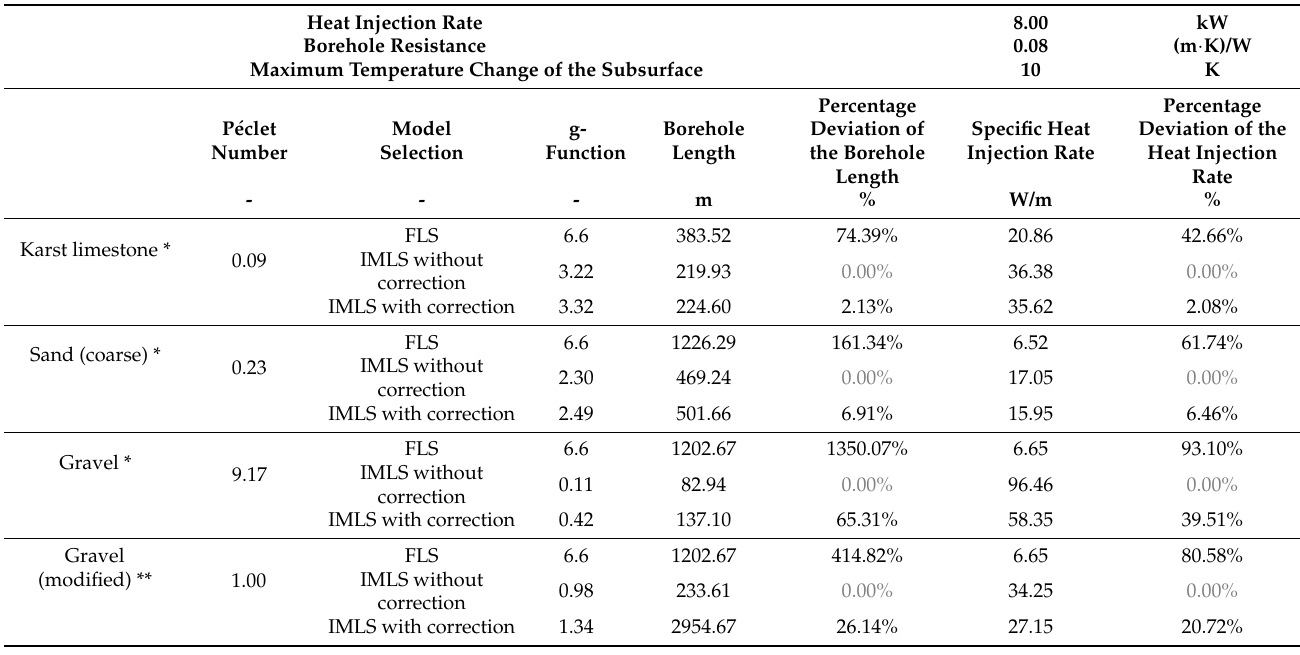
Table 4. Calculation example for the four cases listed in Table 3.